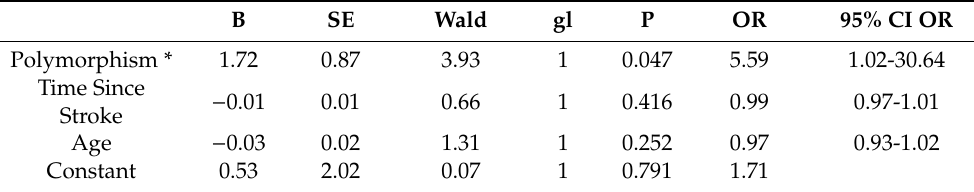
Table 2. Logistic regression